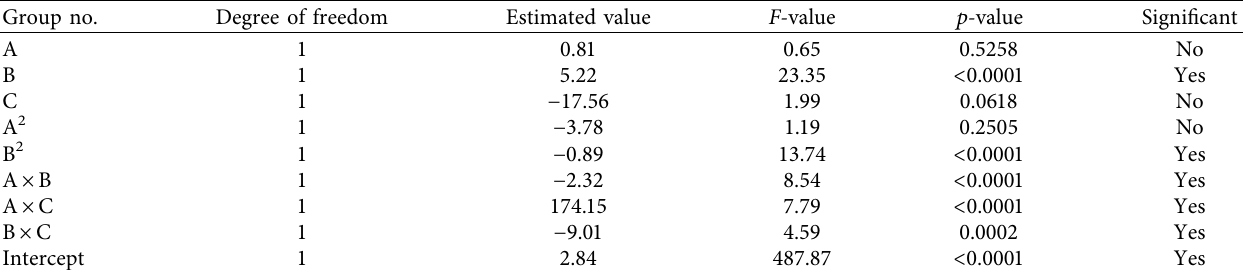
Table 7: Fitted quadratic equations of weight loss after 120 salt freeze-thaw cycles at air content of (6.5 ± 0.5)%. Group